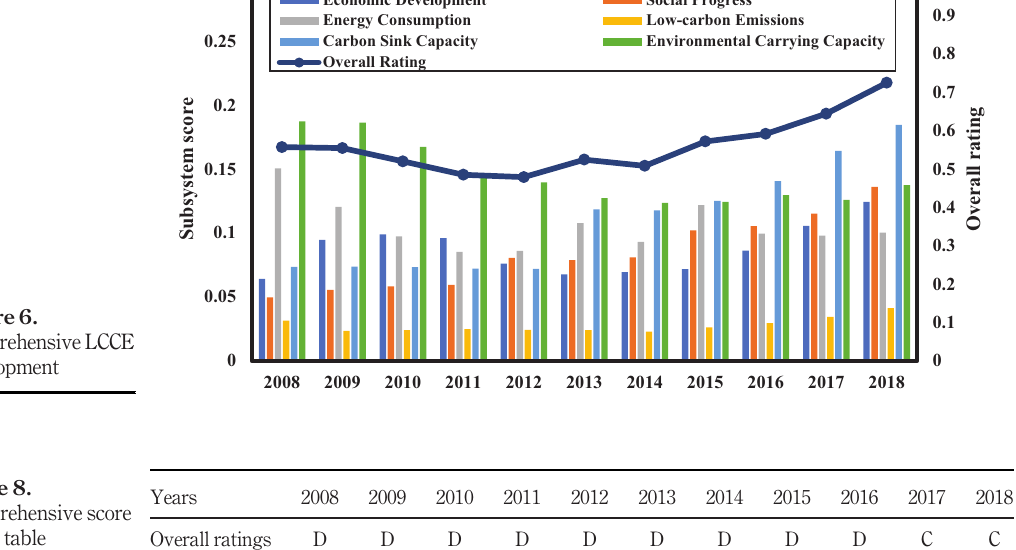
Table 8. Comprehensive score grade